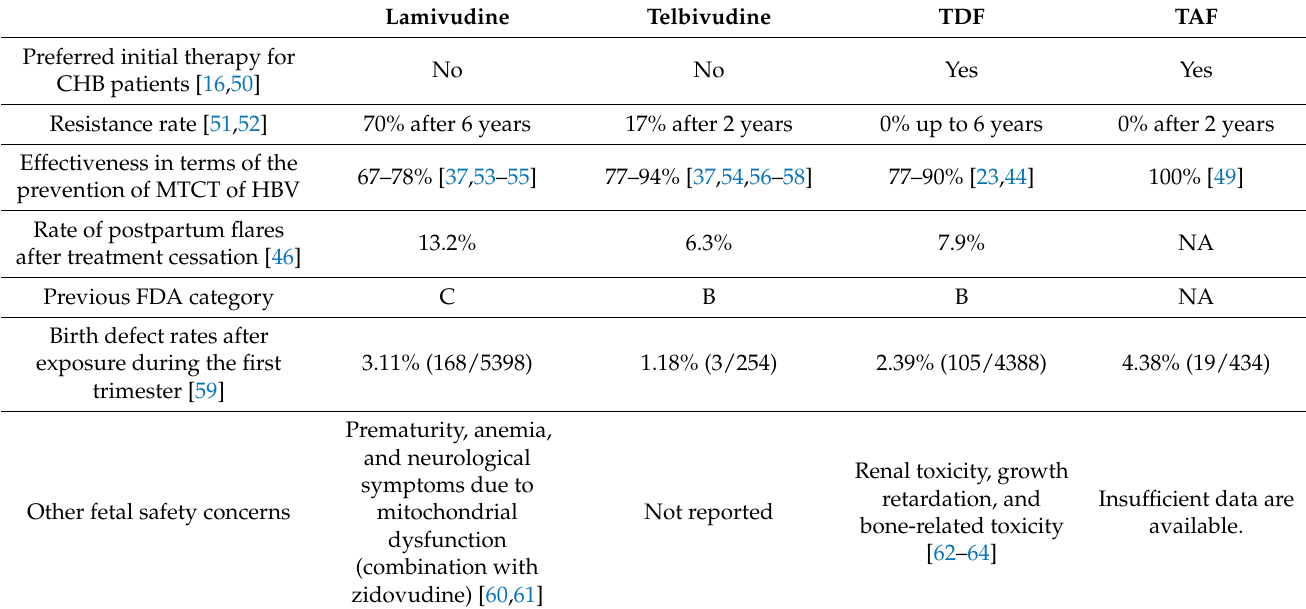
Table 1. Summary of antiviral agents used for HBV infection during